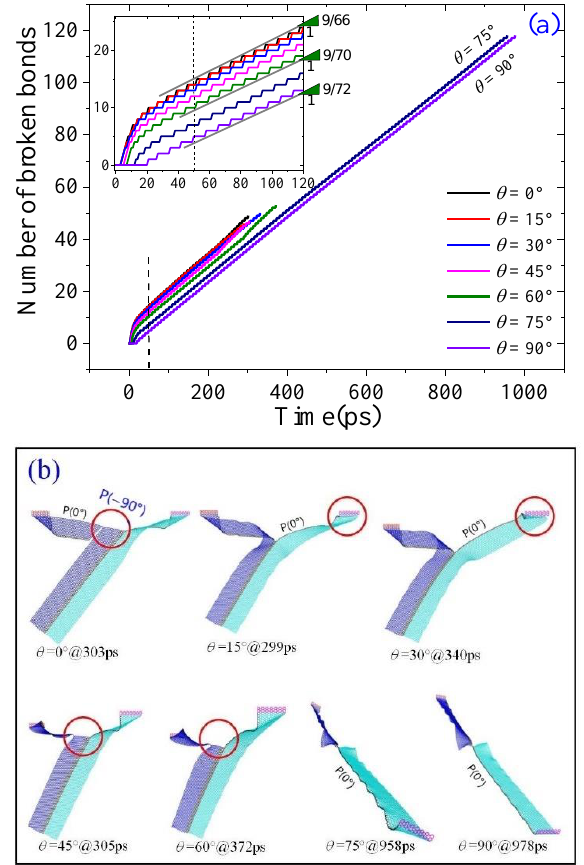
Figure 13. Results of a graphene sheet in oblique tearing conditions with v = 0.6 Å/ps at 1 K: ( a ) numbers of broken bonds, ( b ) the snapshots of the sheet torn in different directions. There are three types of tearing results. For example, when θ =75 ◦ or 90 ◦ , the